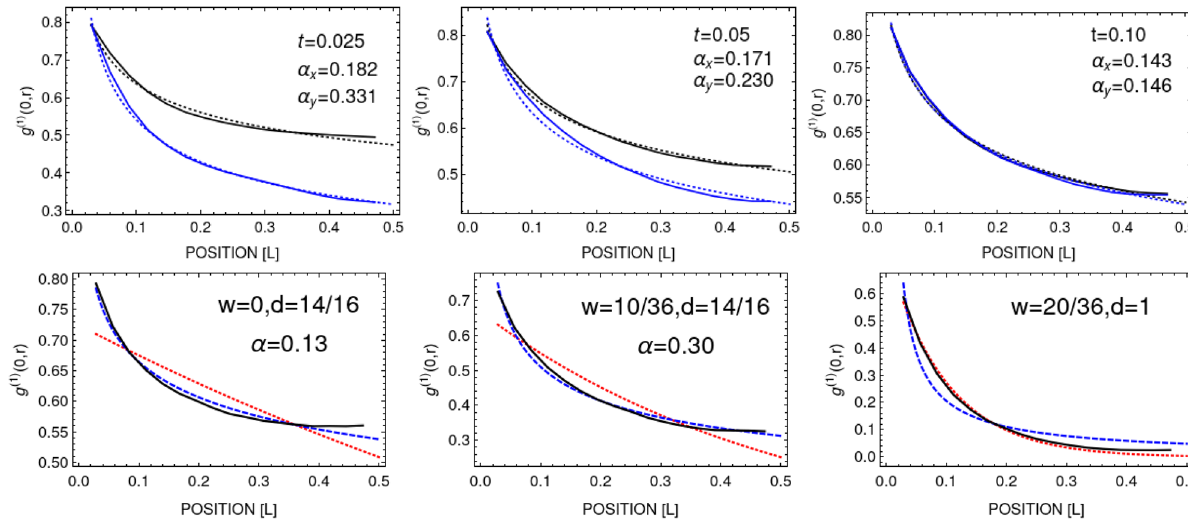
Figure 7. Upper row: First-order correlation function, g ( 1 ) ( r ) , at various times, showing how the system 0.56 . Then, a strong perturbation enters the BKT phase. Initially, the system is prepared at temperature T / T c = 12 / 34 and d 14 / 16 is applied. For times shorter than 0.1mL 2 / (cid:31) the correlations characterized by w / L = = develop but are not yet spatially uniform (left and middle frames, solid black (blue) lines show correlations 1 / r α with exponents given in the legends. For longer times (right frame) along x ( y ) axis). Dashed lines are fits ∼ 0.8 the system already exhibits quasi-long-range order. Lower row: g ( 1 ) ( r ) function at longer times for T / T c = 1 10 / 36 and d 14 / 16 (middle frame), and w / L 20 / 36 and d and no perturbation (left frame), w / L = = = = (right frame). For stronger disturbance transition to the normal phase with exponential decay of correlations is observed (red dotted curve shows the best exponential